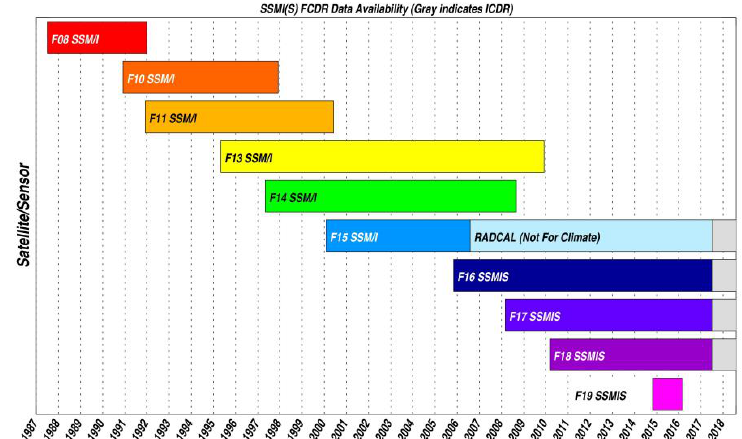
Figure 1. The availability of SSMI(S) FCDR data from the series of ten DMSP conical-scanning imaging radiometers. The gray shaded portion of the bars indicates ICDR or interim data availability for those sensors continuing to operate. A radar calibration (RADCAL) beacon was turned on in August of 2006 on F15, which substantially impacted the 22 GHz Tb, and F19 lost communications a bit over a year after the SSMIS data became operational. Corrections have been applied for the RADCAL affected F15 data, but significant residual errors remain making it unsuitable for climate